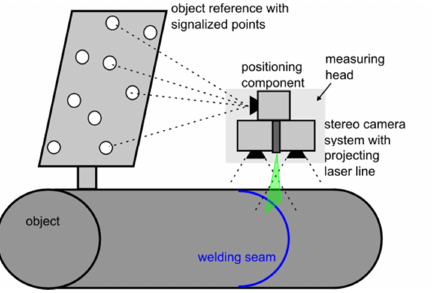
Figure 2. Principle of the acquisition of the weld geometry with a stereo camera system in combination with a projecting line laser and a positioning unit